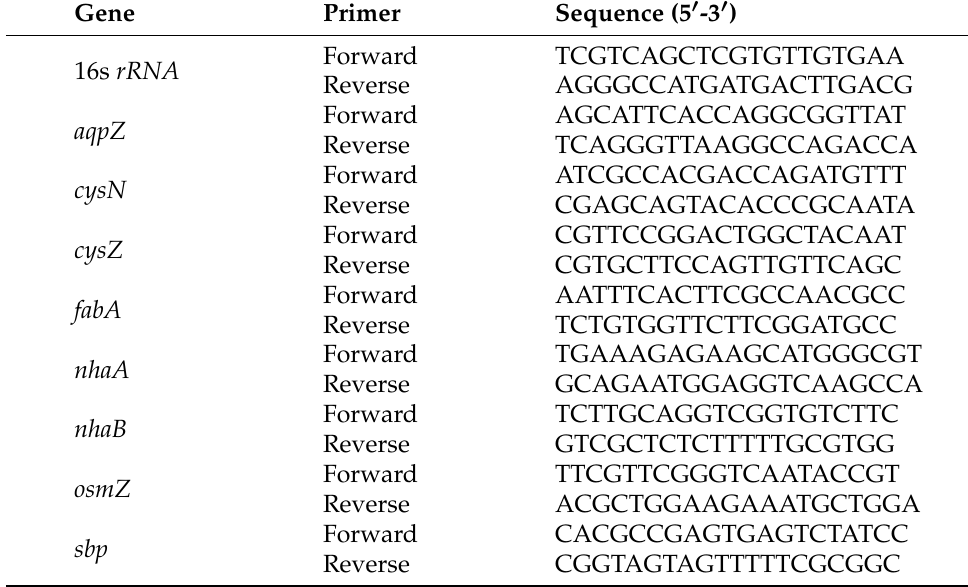
Table 2. List of the primers